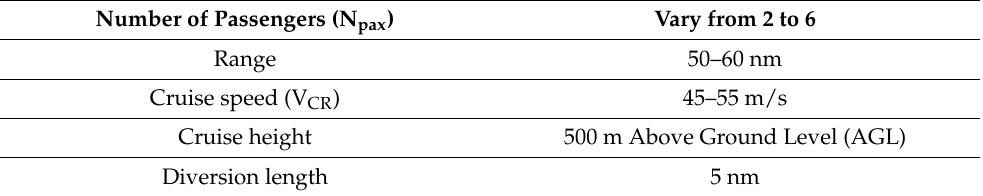
Table 3. TLARs for